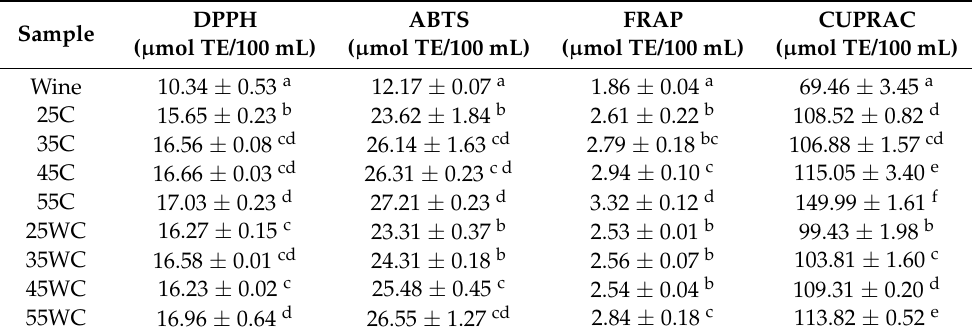
Table 7. Antioxidant capacity determined by four methods of the initial Cabernet Sauvignon wine variety and retentates obtained by nanofiltration at 25, 35, 45, and 55 bar with cooling (C) and without cooling